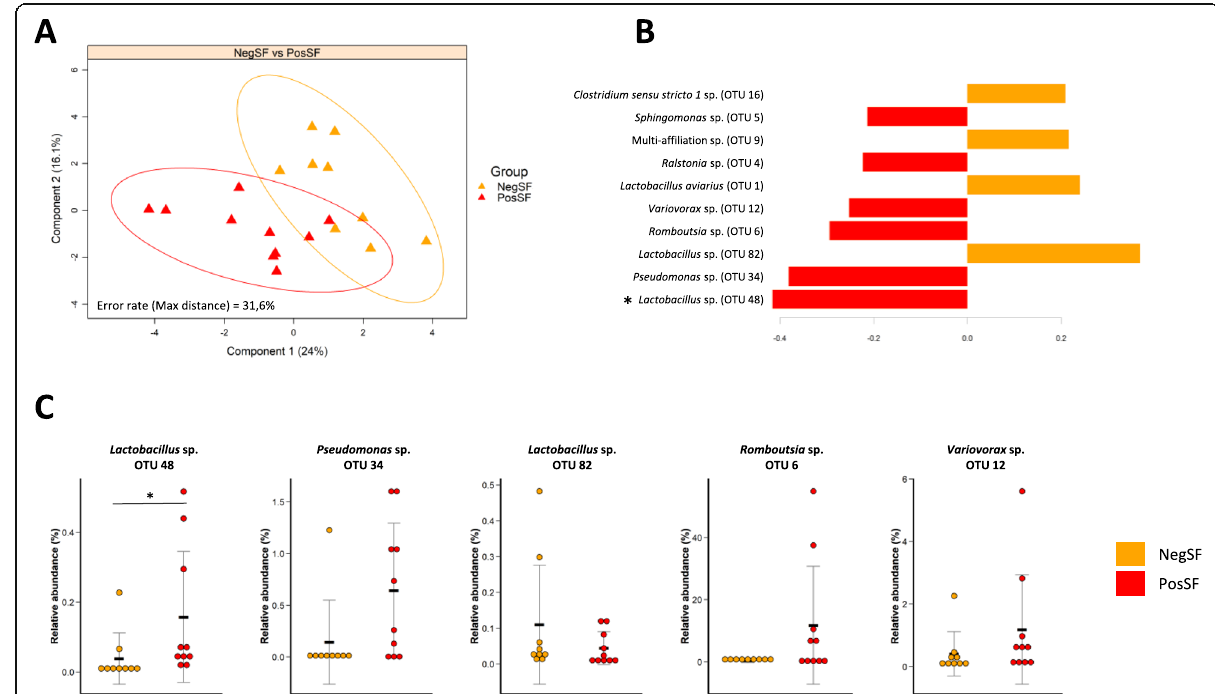
Fig. 4 PLS-DA analysis on PosSF and NegSF groups based on OTUs. Analysis was performed using only OTUs with abundances > 0.1% in at least one group. a In the sample scatter plot each triangle represents a goose. Geese can be discriminated according to steatosis group on component 1. b Contribution level of the top 10 OTUs on component 1 are represented. The bar length represents the importance of the variable in the multivariate model. Bars are colored according to the experimental group with the highest mean abundance. c Relative abundance of the 5 most discriminant OTUs. NegSF: Negative response groupe to spontaneous fattening induction, PosSF: Positive response groupe to spontaneous fattening induction. * Significant difference between the PosSF and NegSF groups ( P < 0.05) according to a